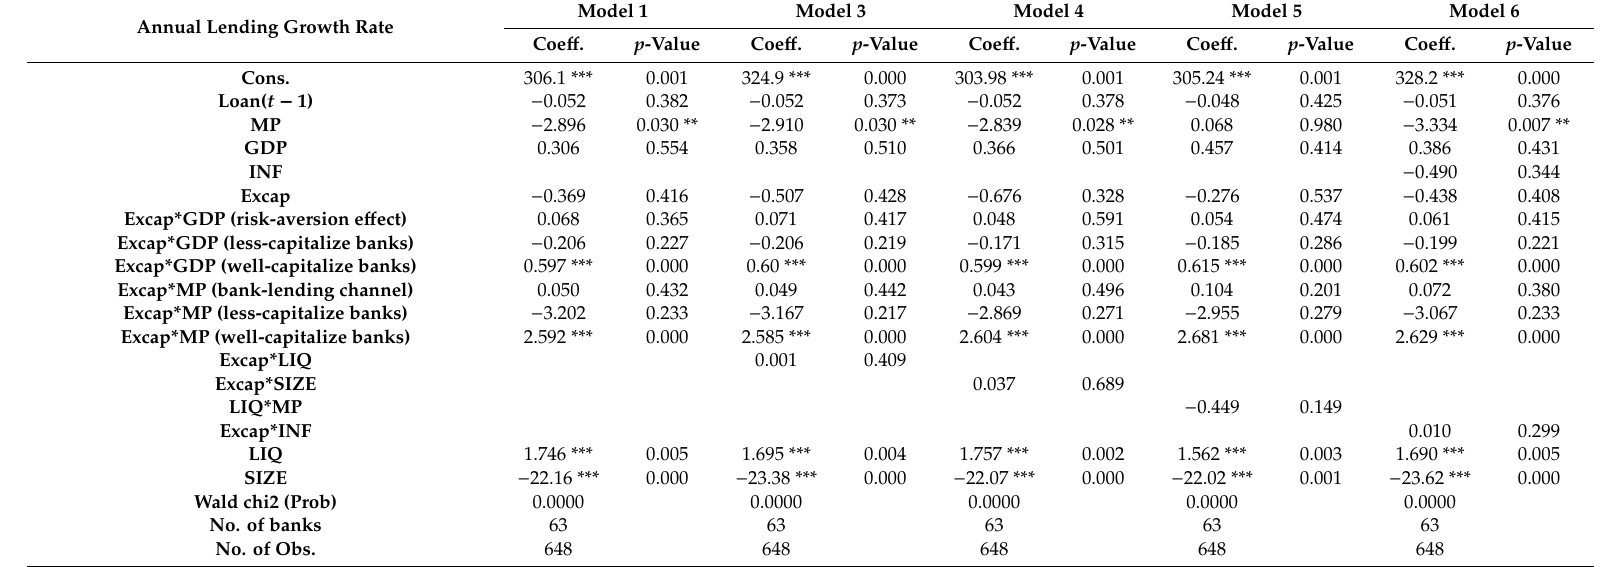
Table A1. South-East region